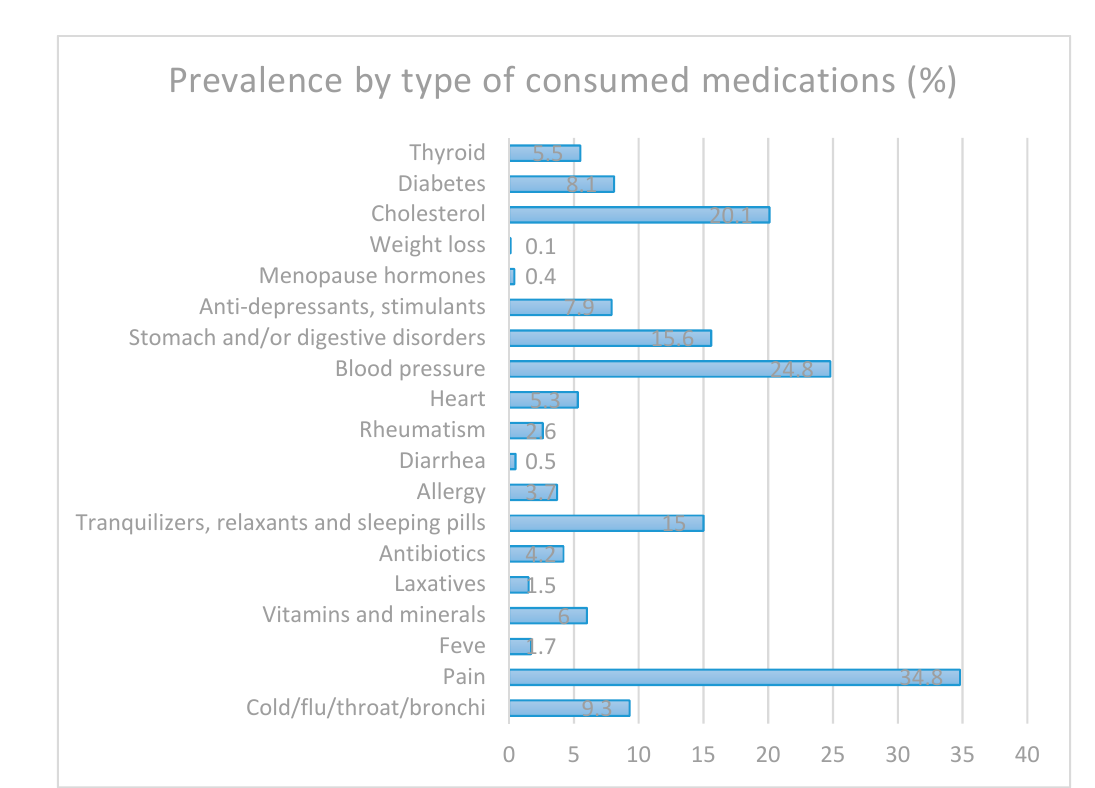
Figure 1. Prevalence of the different groups of medications consumed by the Spanish pre-elderly. Pre-elderly individuals who had low levels of PA consumed more drugs, as did peo- ple who had a case of mental health vulnerability or multimorbidity ( p < 0.001). Figure 2 shows the ROC curve for cases of mental health vulnerability (Figure 2a) [area under the curve (AUC) = 0.775, 95% CI = 0.734–0.776; p < 0.001, the cut-off point was 1.5 drugs (sen- sitivity = 0.669, 1-specificity = 0.423)], depression in the last 12 months (Figure 2b) [AUC = 0.835, 95% CI = 0.818–0.853; p < 0.001, the cut-off point was 2.5 drugs (sensitivity = 0.755, 1-specificity = 0.233)], anxiety in the last 12 months (Figure 2c) [AUC = 0.803, 95% CI = 0.784–0.821; p < 0.001, the cut-off point was 1.5 drugs (sensitivity = 0.867, 1-specificity = 0.415)] and multimorbidity (Figure 2d) [AUC = 0.825, 95% CI = 0.815–0.835; p < 0.001, the cut-off point was 1.5 drugs (sensitivity = 0.669, 1-specificity = 0.127)] predicted by the num- ber of medications consumed in the last 2 weeks.